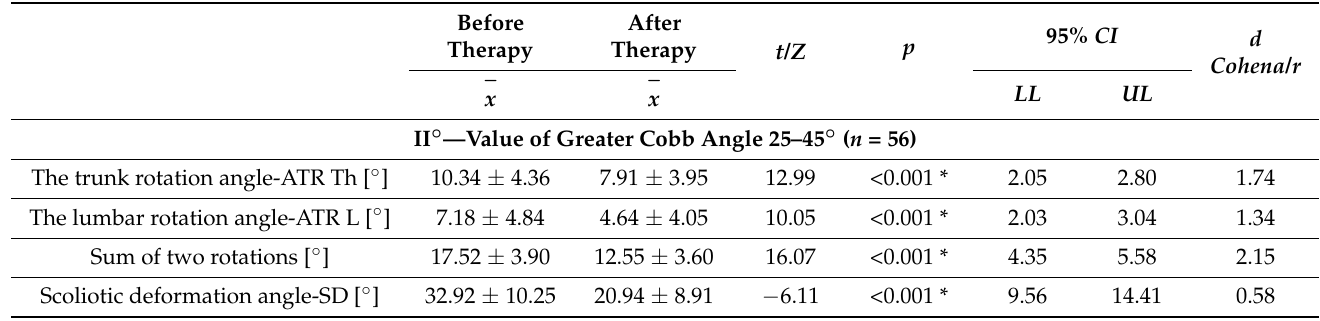
Table 6. Results of Student’s t -test for dependent samples and Wilcoxon’s test-comparison of individ- ual parameters measured with the scoliometer and Zebris, before and after therapy, with division into groups distinguished on the basis of the value of greater Cobb